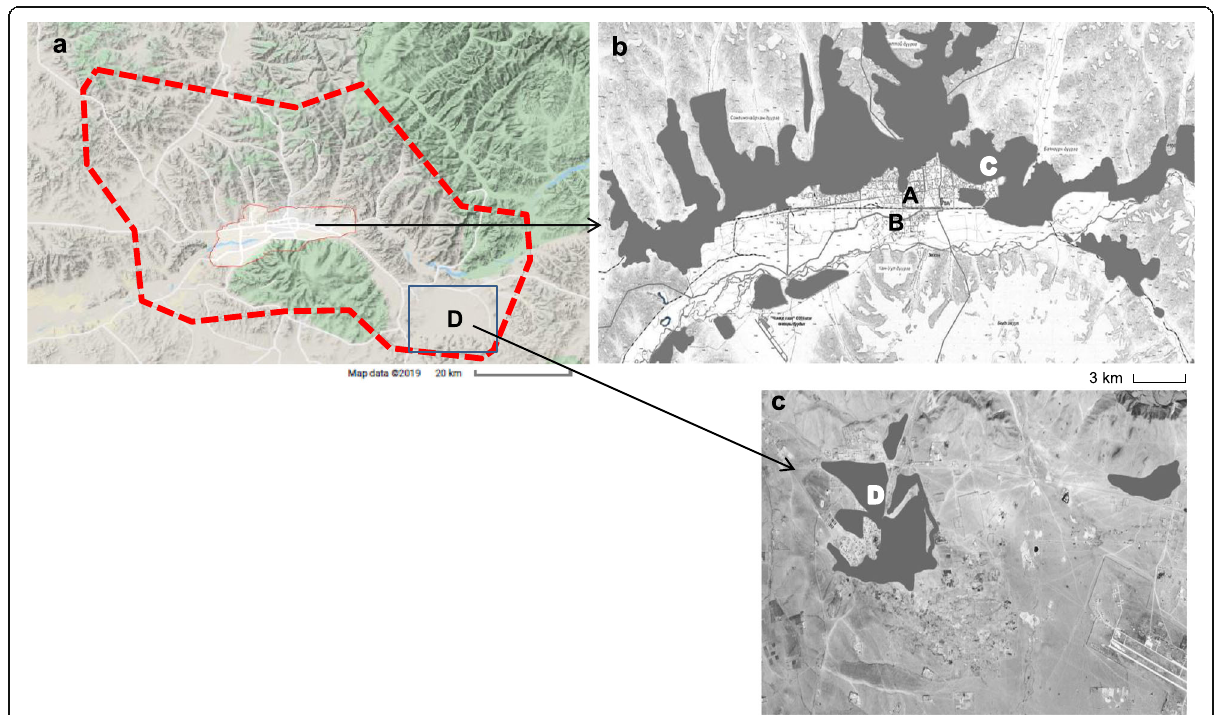
Fig. 1 a Map of Ulaanbaatar. b The locations of the urban study sites; A, B: apartments (white), C: “ gers ” (black). c The location of the suburban site; D: apartments (white), “ gers ”